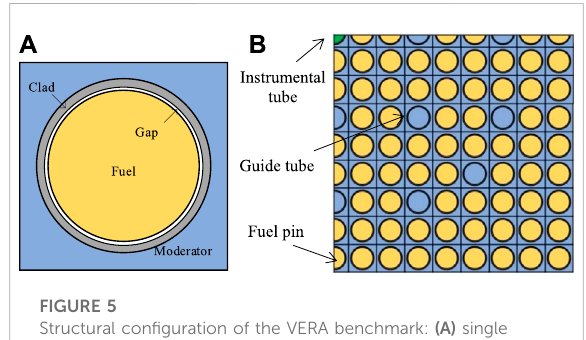
FIGURE 5 Structural con fi guration of the VERA benchmark: (A) single cell and (B) 1/4